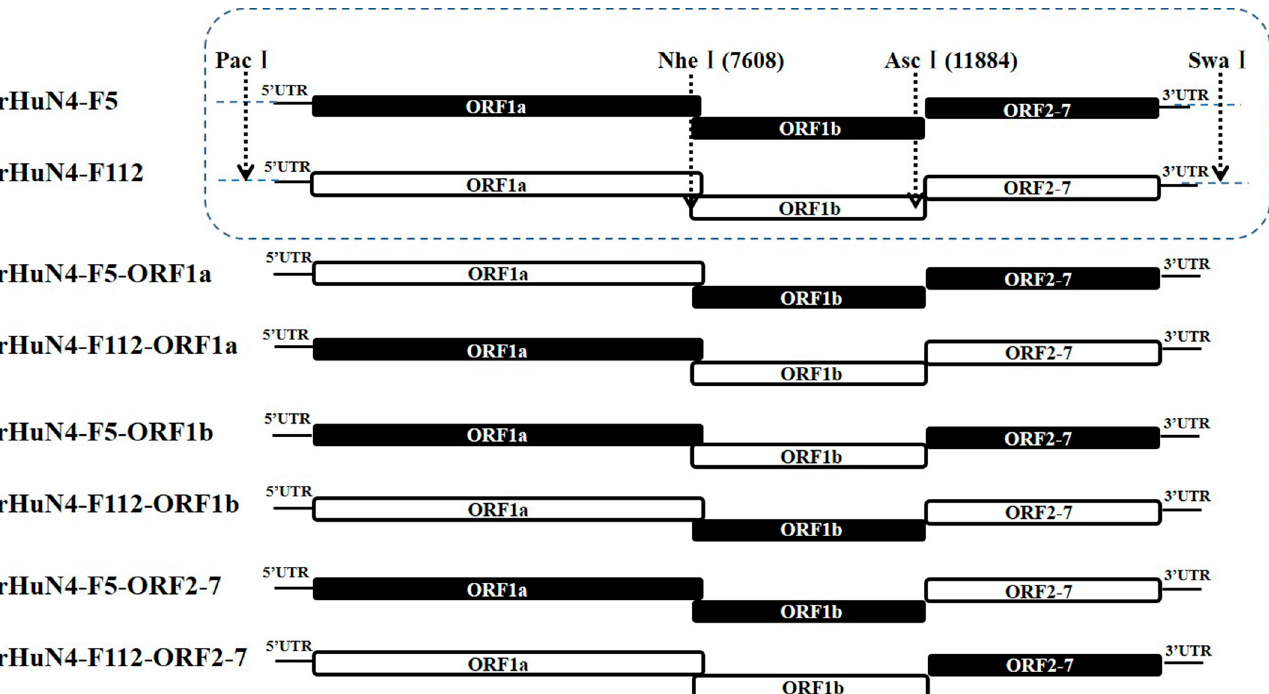
Figure 1. Construction schematic of Chimeric PRRSVs. For the chimeric viruses with backbone of HuN4-F5 or HuN4-F112, PacI and NheI were used to interchange the 5 ′ UTR + ORF1a region, NheI and AscI were used to interchange the ORF1b region, AscI and NotI were used to interchange the ORF2-7 + 3 ′ UTR region. The regions from HuN4-F5 backbone were indicated in black and those from HuN4-F112 backbone were indicated in white.